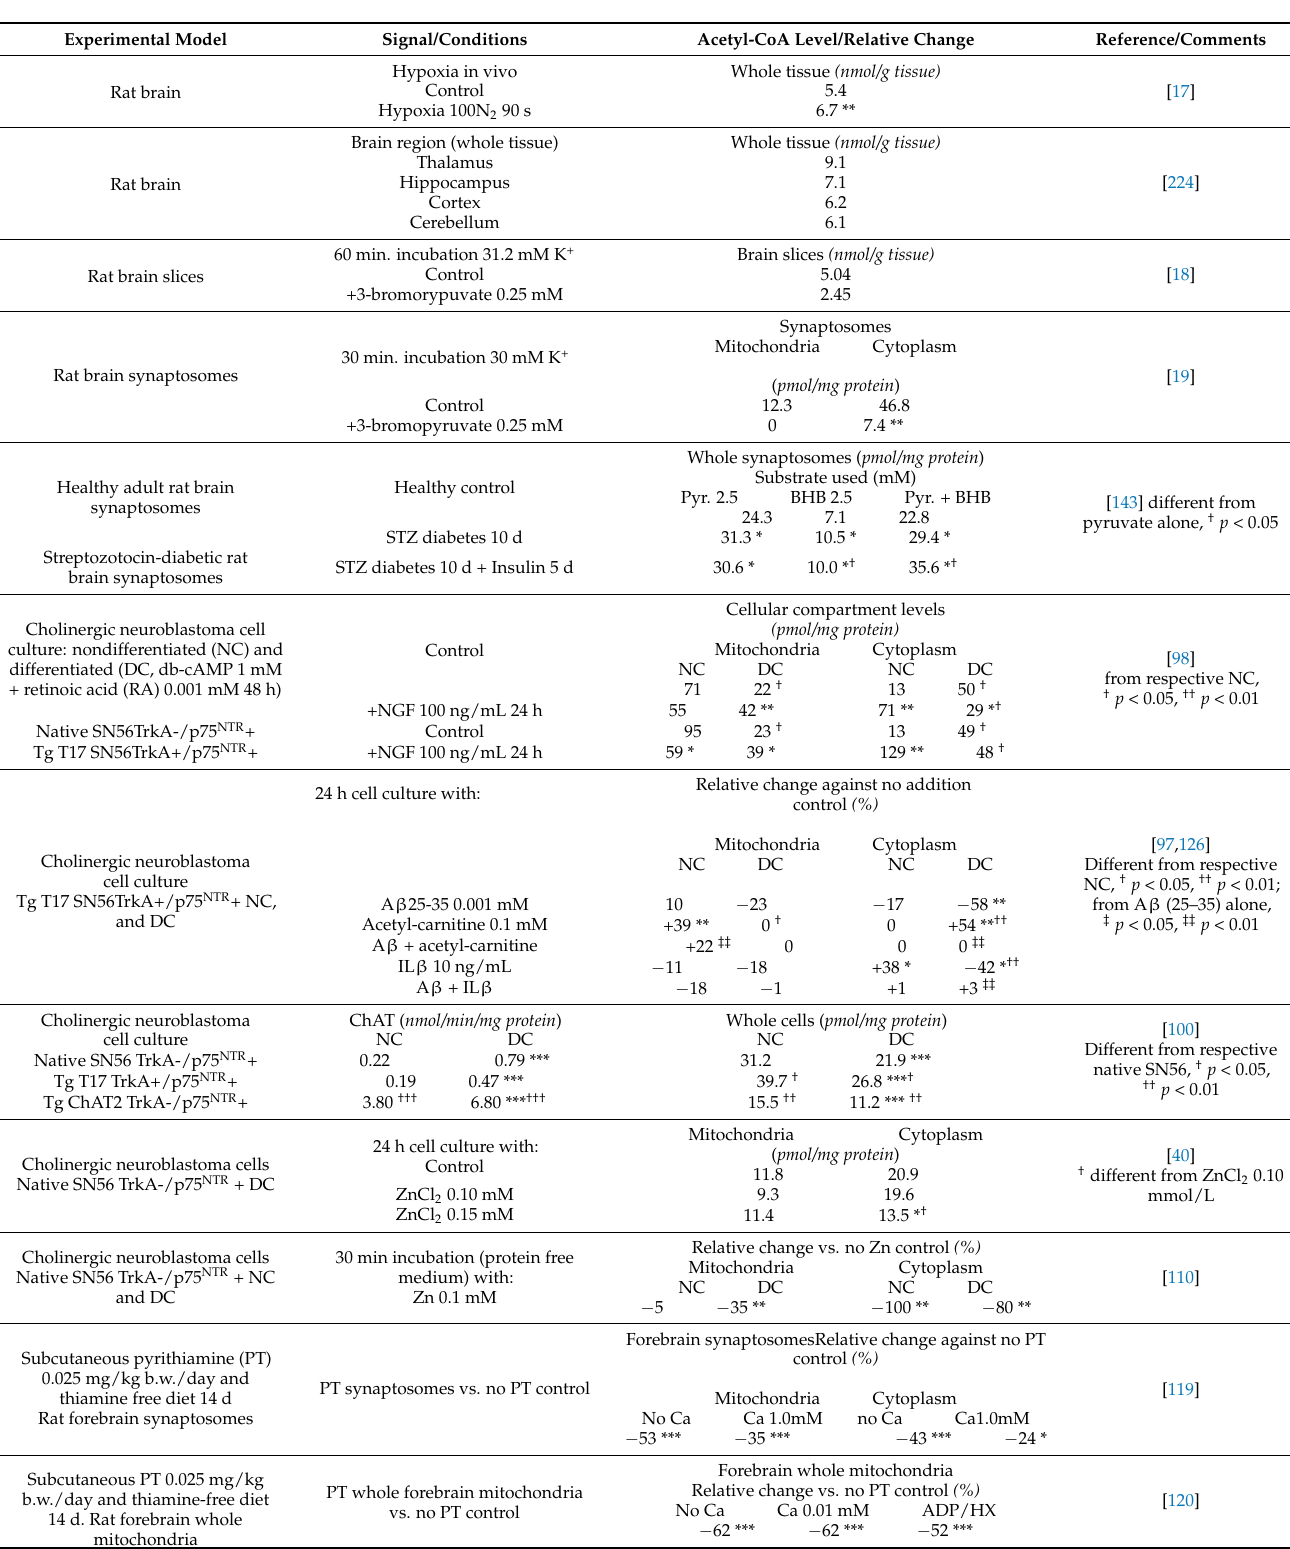
Table 1. Levels of acetyl-CoA in different brain compartments in various experimental models of brain pathologies. Historic